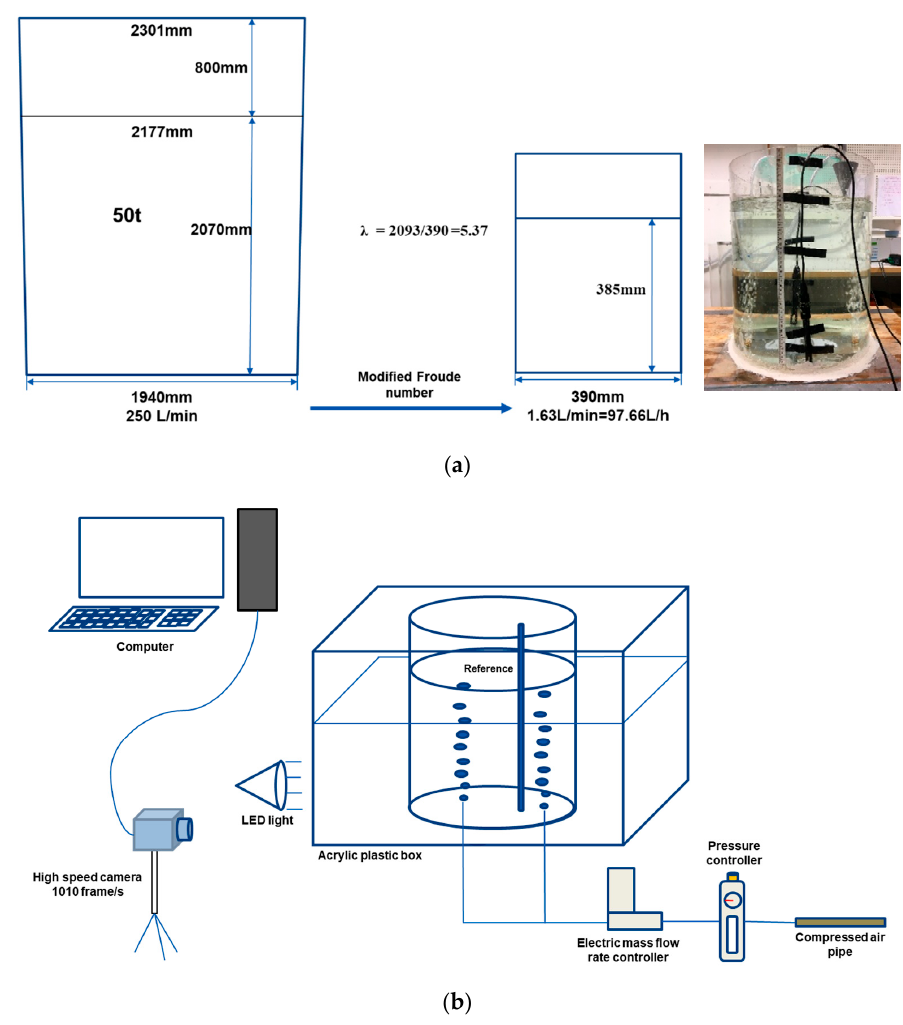
Figure 1. Scaling criterion ( a ) and experimental apparatus ( b ).